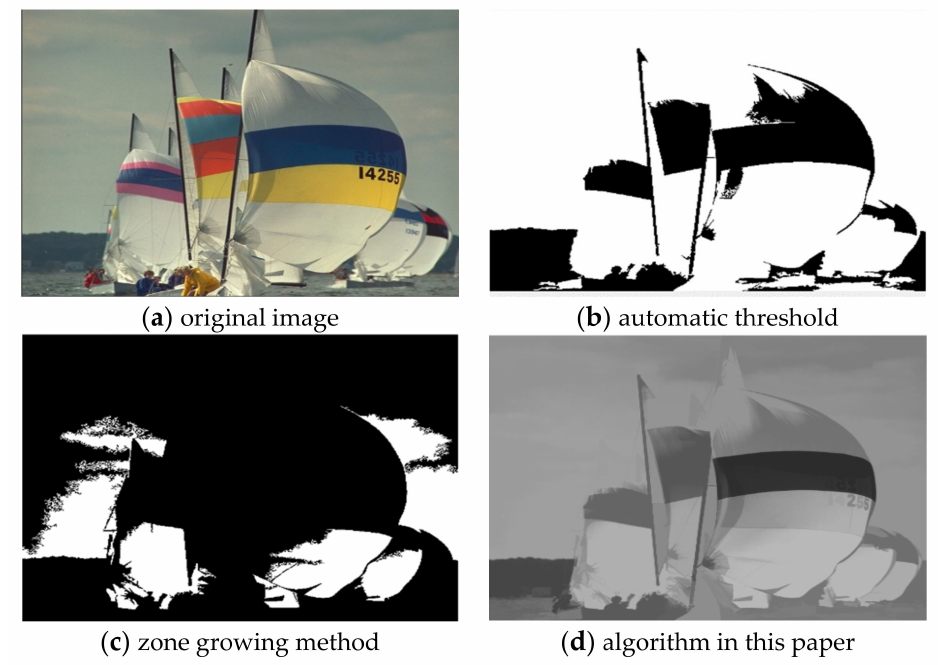
Figure 8. Comparison of Sailing image segmentation results.